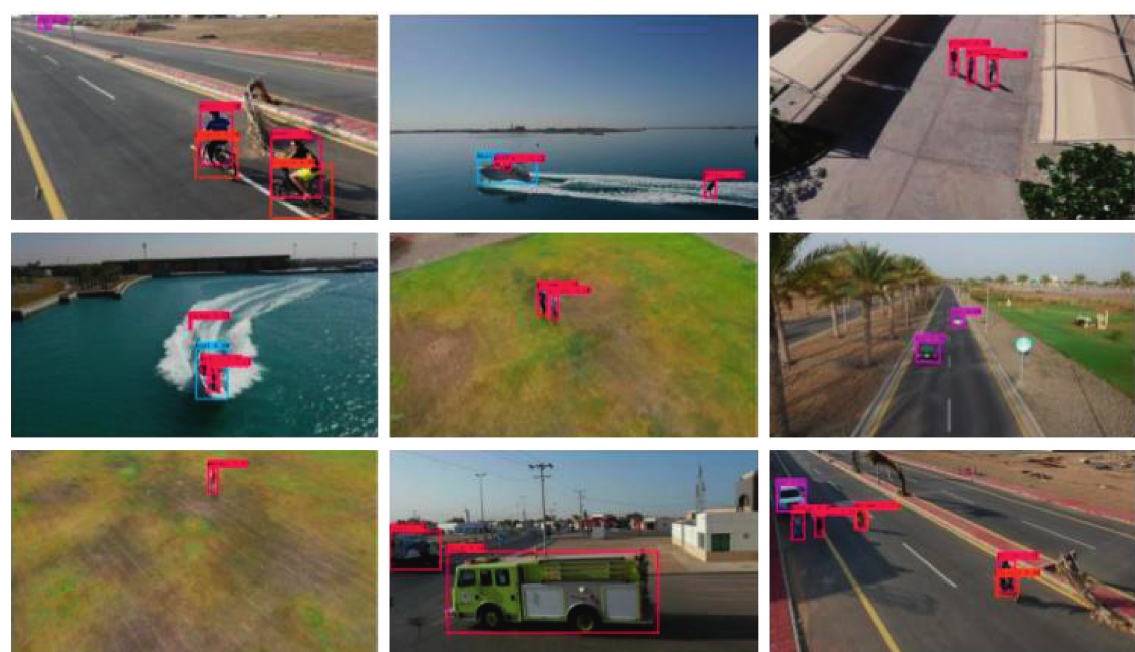
Figure 9: Detection examples generated by MFFNet-101 as backbone networks on UAV123 dataset. MARNet-101 is trained on the VOC 2007 trainval+